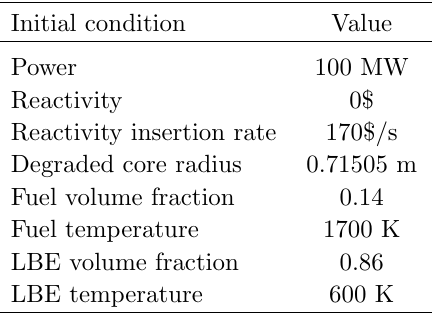
Table 2. Timing of the most important events expected to occur during the HCDA in MYRRHA. These results are obtained by employing HCDA